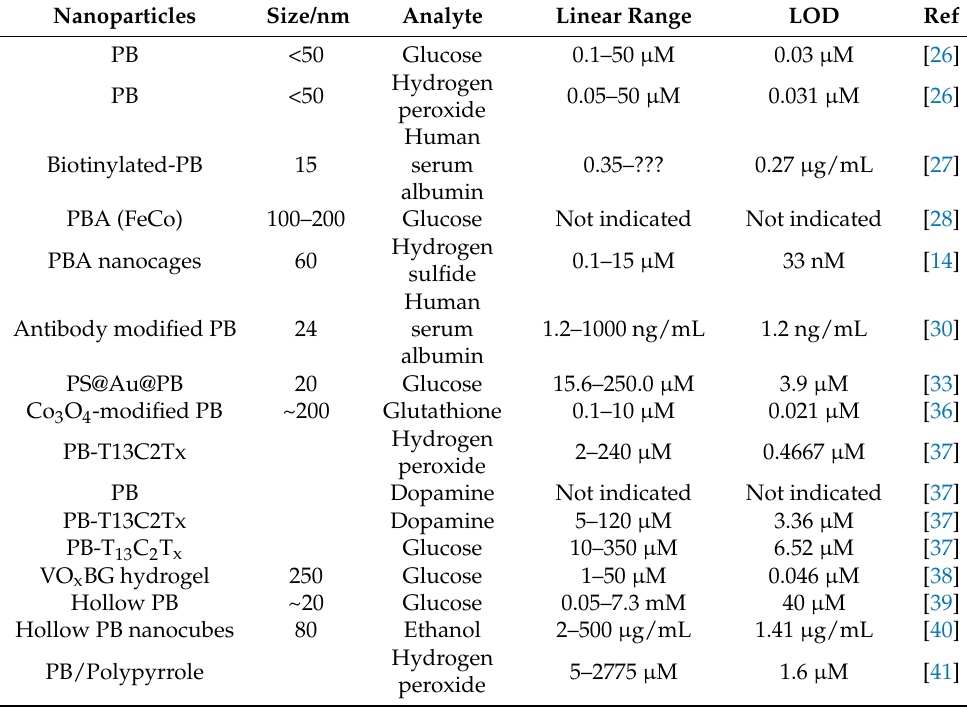
Table 1. Prussian blue nanoparticles used as sensors. LOD = limit of